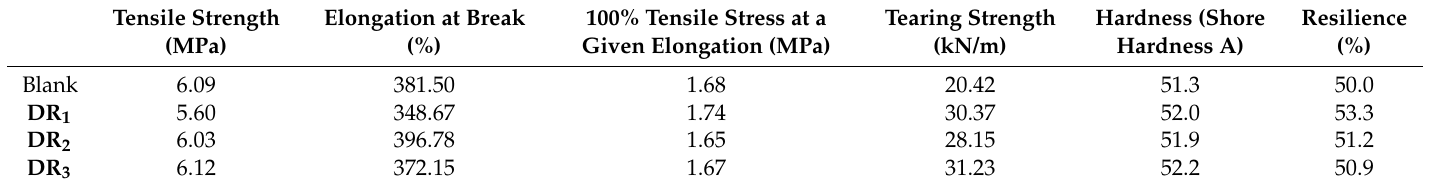
Table 3. Static mechanical properties of the rubbers colored with red silicon-containing reactive disperse dyes.